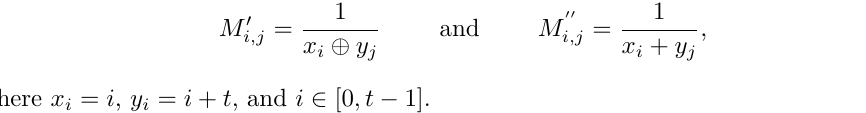
Table 6: Vulnerable matrices for Algorithm 1 and orders t and field sizes n = d log when considering the Starkad and Poseidon